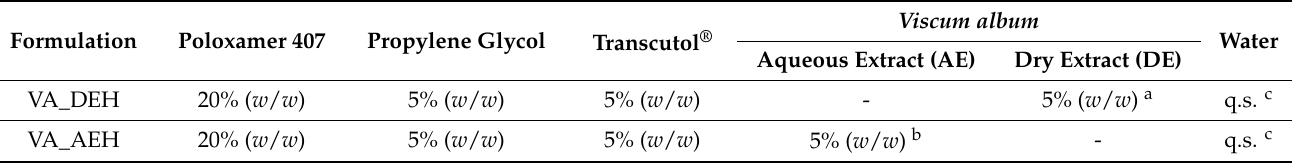
Table 1. Viscum album hydrogels